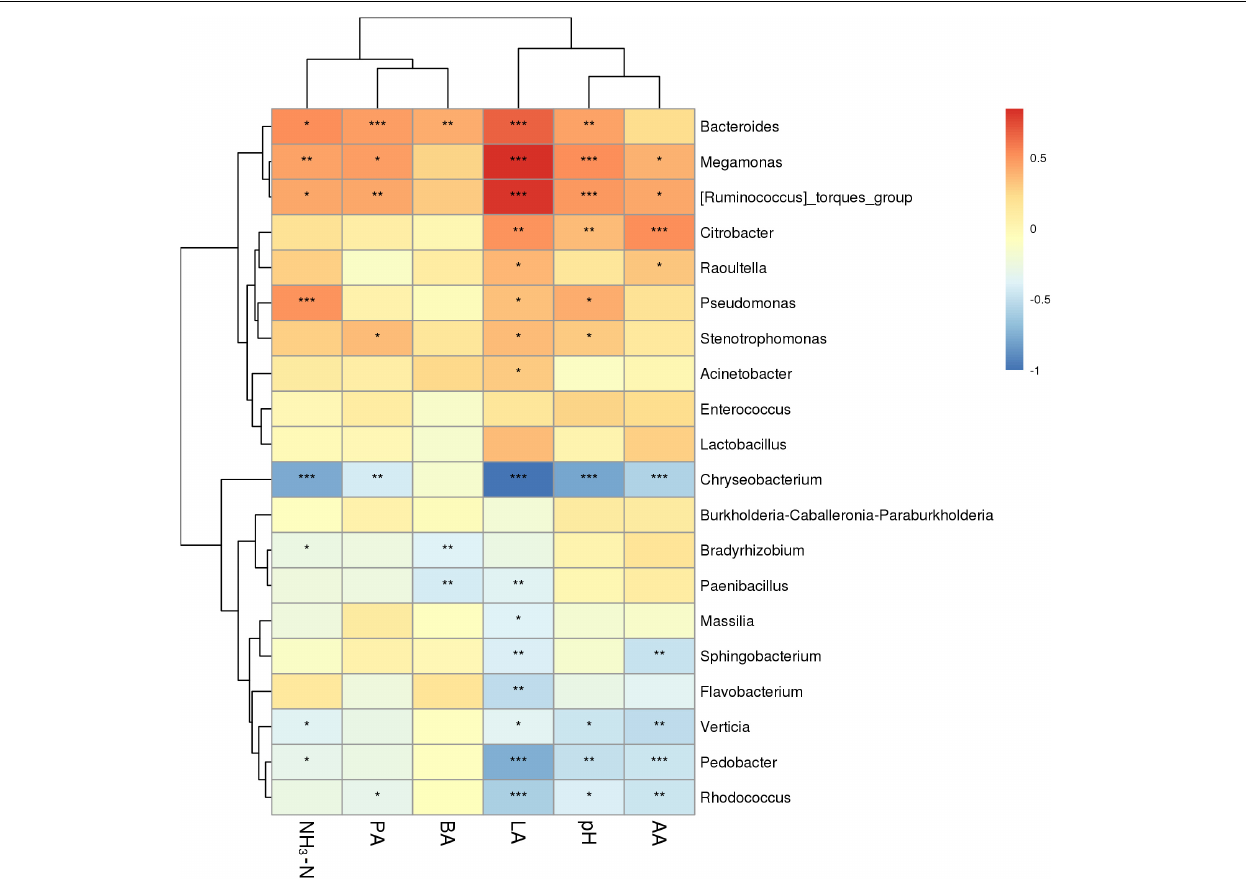
FIGURE 4 | Correlation analysis of P. sinese silage bacterial communities and fermentation characteristics at genus level. The blue indicates a negative correlation, red indicates a positive correlation. “*,” “**,” and “***” represent P < 0.05, P < 0.01, and P < 0.001, respectively.